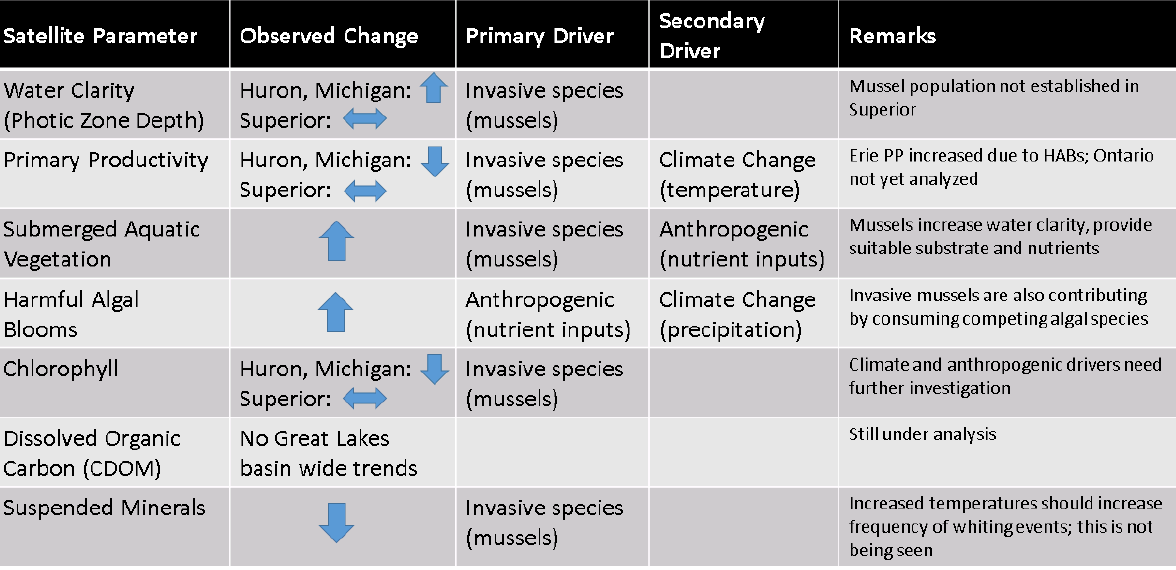
Table 9: Summary of satellite observed water quality changes along with the drivers of the